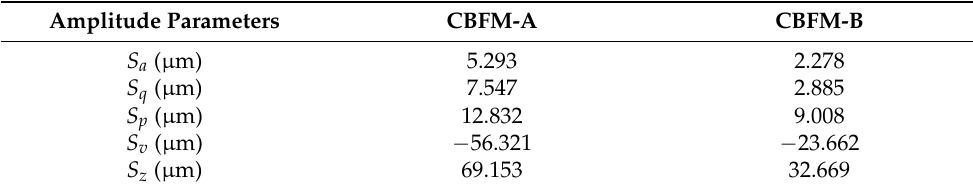
Table 3. Morphology parameters of pre-test surface of CBFM-A and CBFM-B.